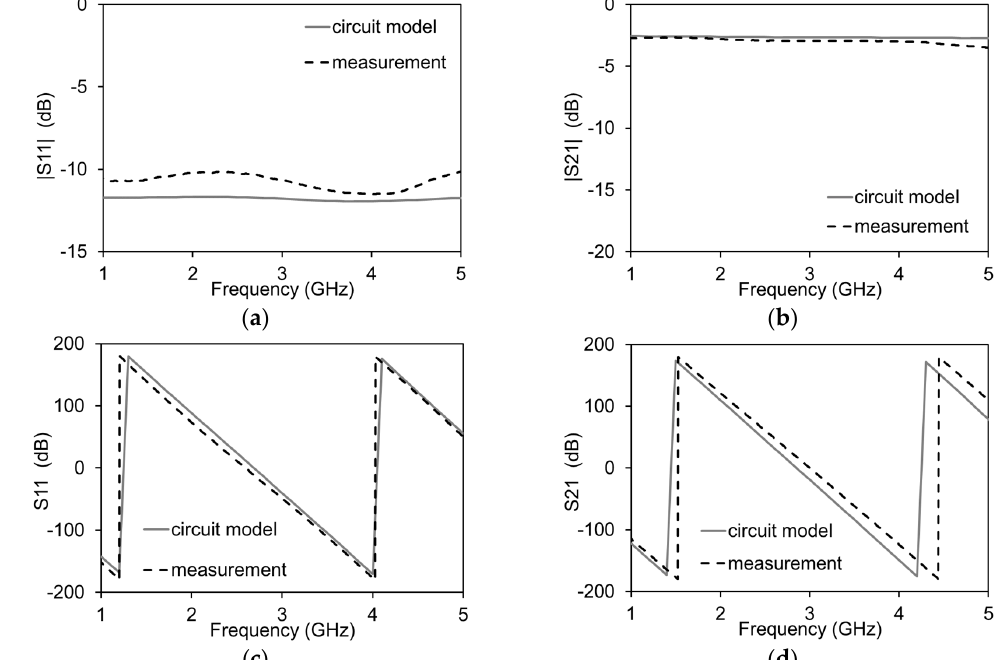
Figure 14. Simulated (solid lines) and measured (dashed lines) scattering parameters of graphene films: ( a ) amplitude of reflection coefficient (dB); ( b ) amplitude of transmission coefficient (dB); ( c ) phase of the reflection coefficient (deg); ( d ) phase of the transmission coefficient (deg).